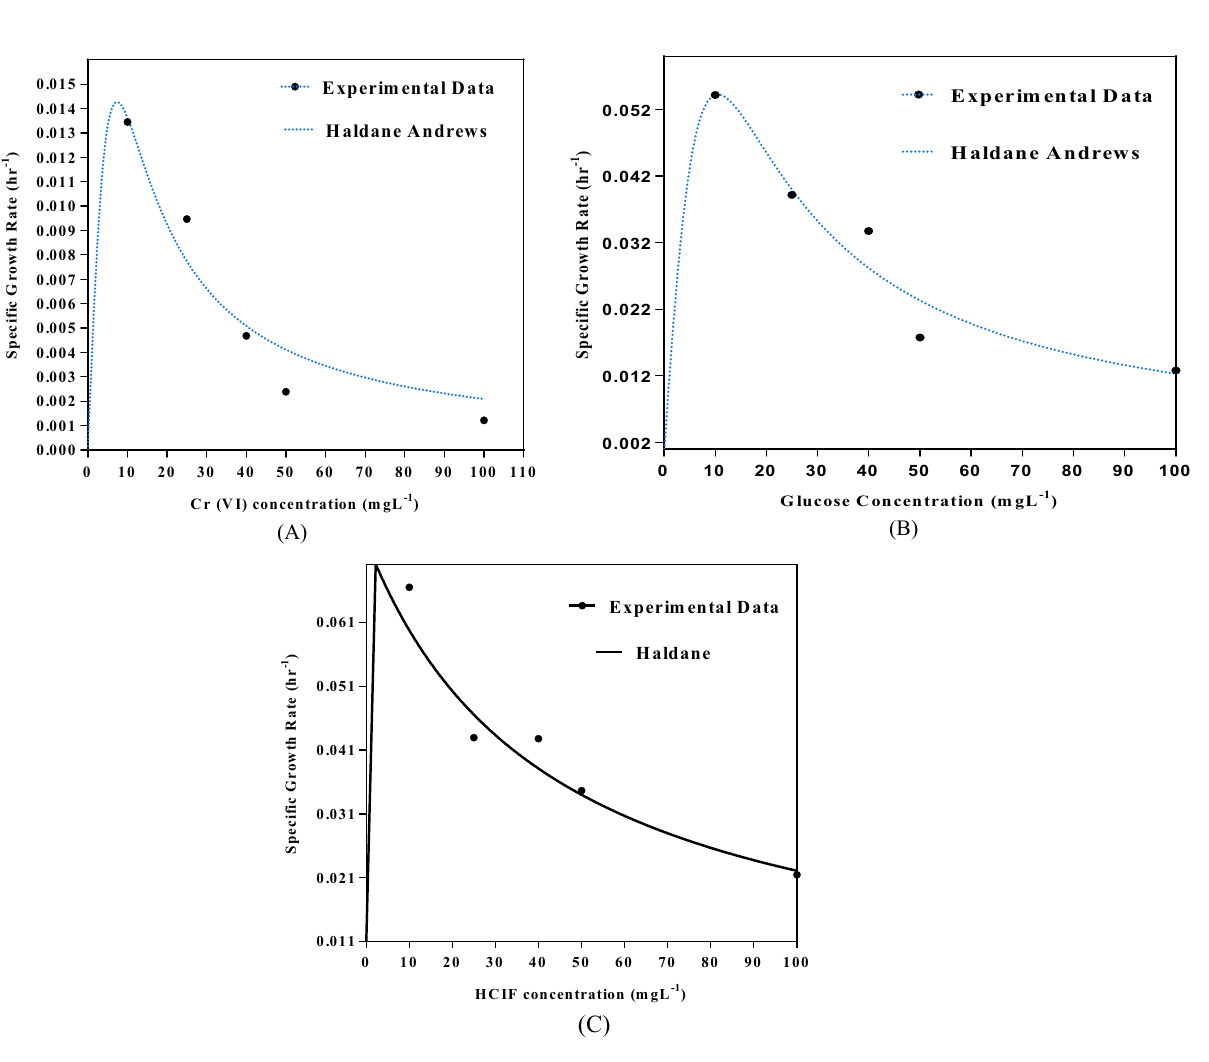
Figure 4. Growth Kinetics modeling in single substrate system ( A ) with respect to Cr(VI) concentration, ( B ) glucose concentration, ( C ) HCIF